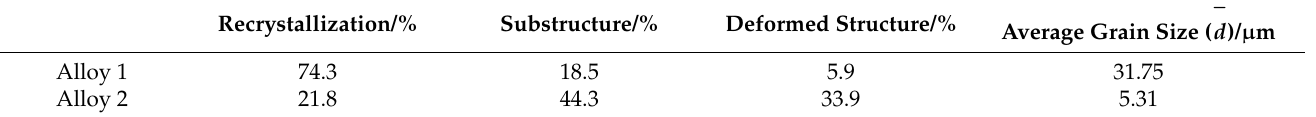
Figure 1. EBSD analysis of alloy 1 ( a , c , e ) and alloy 2 ( b , d , f ) after hot extrusion: ( a , b ) IPF; ( c , d ) GOS; ( e , f ) grain size distribution. Table 2. Comparison of statistical microstructure characteristics for two categories of extruded Al- 5Mg alloys.